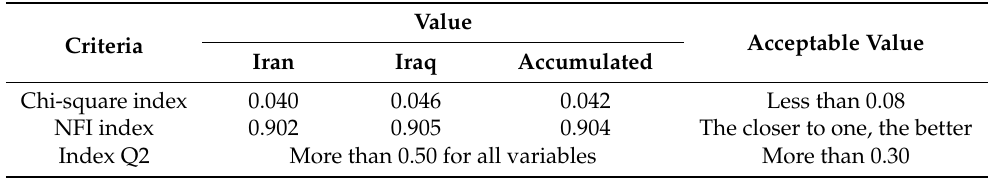
Table 5. The goodness of fit criteria.